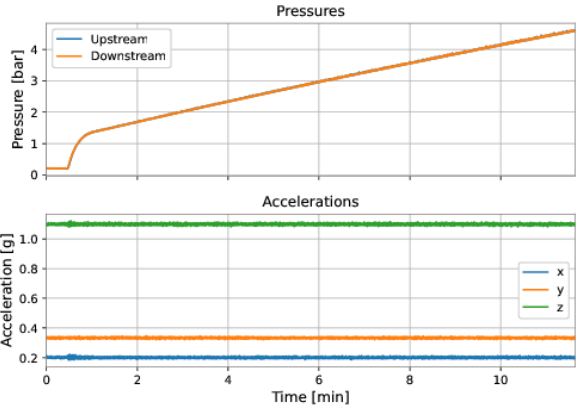
Figure 38. Examples of samples that did not belong to the interest’s regions for the model’s training and, hence, were discarded from the dataset. Initial pressurization of the pipeline.